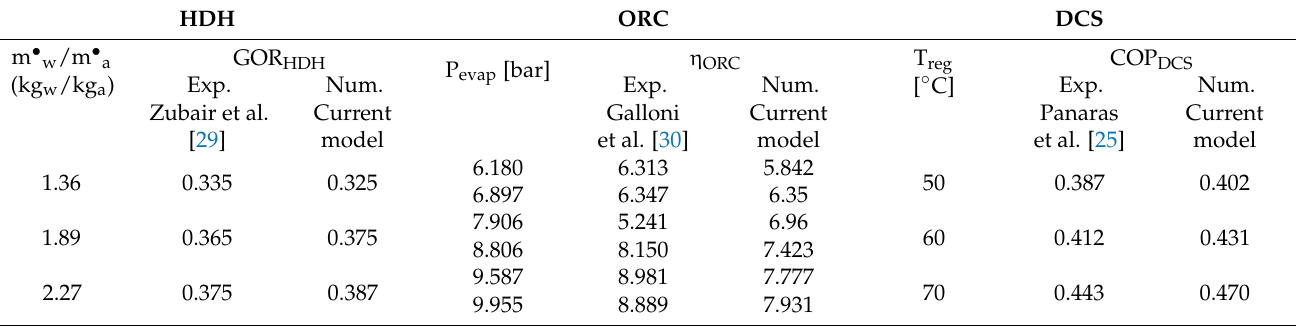
Table 3. Validation of the current model with the published data for HDH, ORC, and DCS systems.